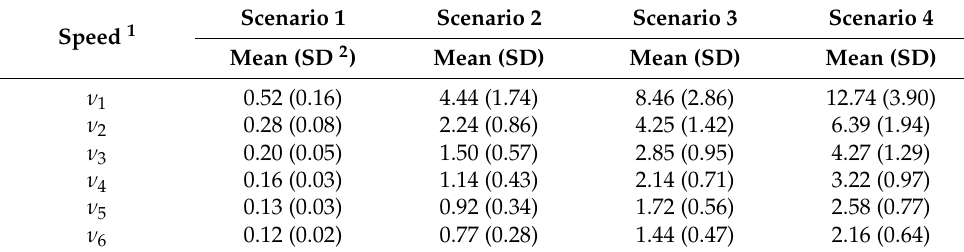
Table 4. Average critical latency value in minutes for each speed. Speed